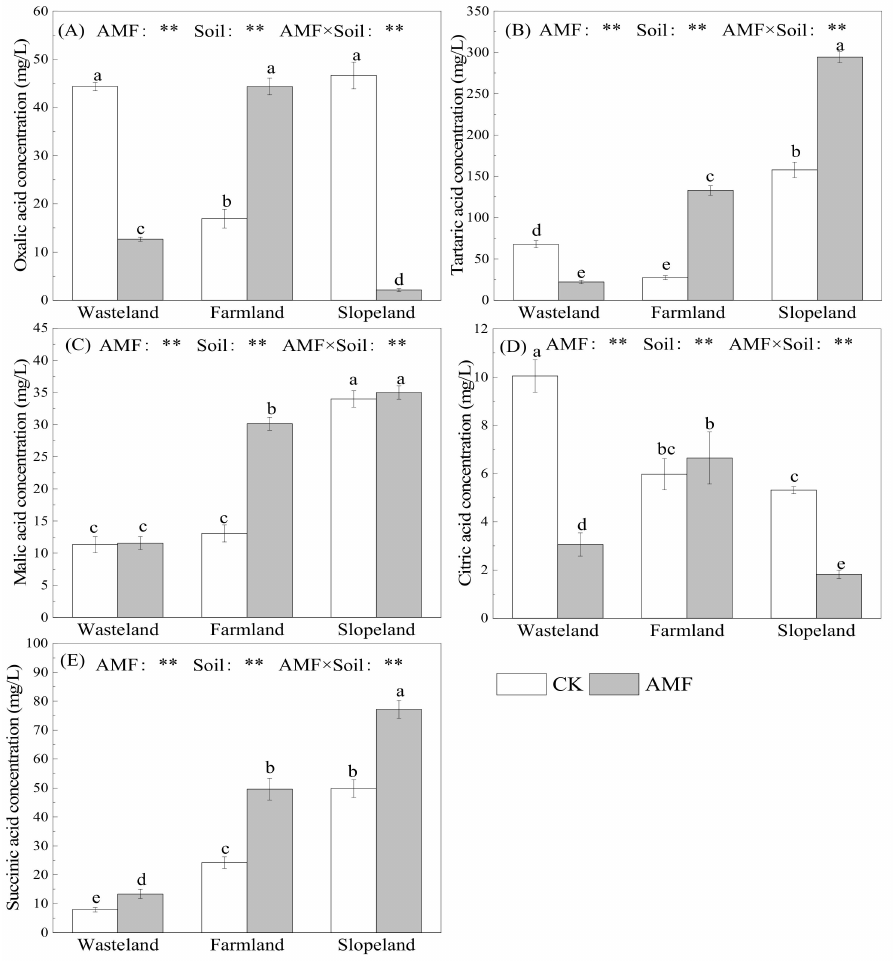
Figure 1. Effects of AMF on low-molecular-weight organic acid concentrations secreted by maize roots. ( A ): the concentration of oxalic acid secreted by maize roots with and without AMF inoculation; ( B ): the concentration of tartaric acid secreted by maize roots with and without AMF inoculation; ( C ): the concentration of malic acid secreted by maize roots with and without AMF inoculation; ( D ): the concentration of citric acid secreted by maize roots with and without AMF inoculation; ( E ): the concentration of succinic acid secreted by maize roots with and without AMF inoculation. The different lowercase letters indicate significant differences among treatments; “**” mean p <